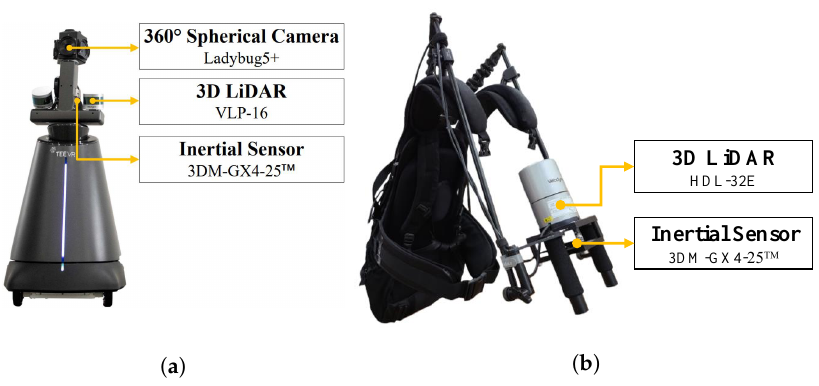
Figure 8. ( a ) Robot system and ( b ) backpack system employed for data acquisition.